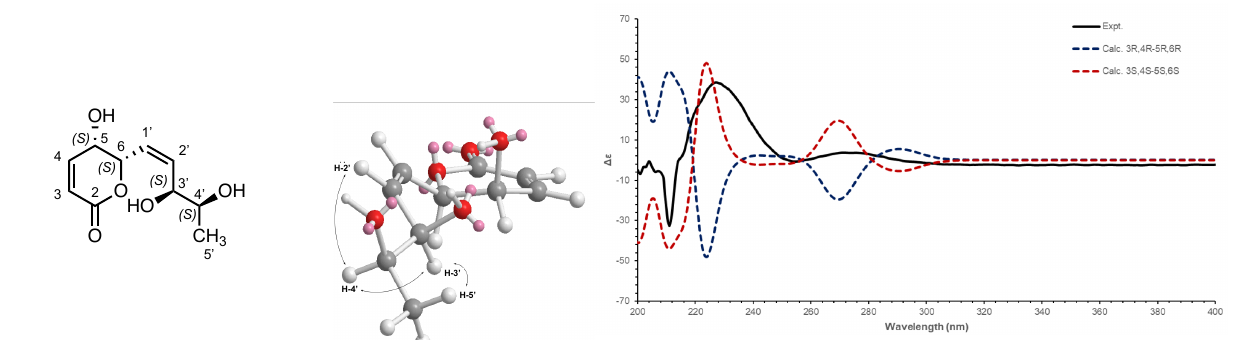
Figure 3. Structure and numbering of compound 2; ROESY correlations observed for the side chain; Experimental (black) and TFT-TD-calculated ECD spectra of the two enantiomers (5 R ,6 R )-6-((3’ R ,4’ R ,Z) (blue) and (5 S ,6 S )-6-((3’ S ,4’ S ,Z) (red) of